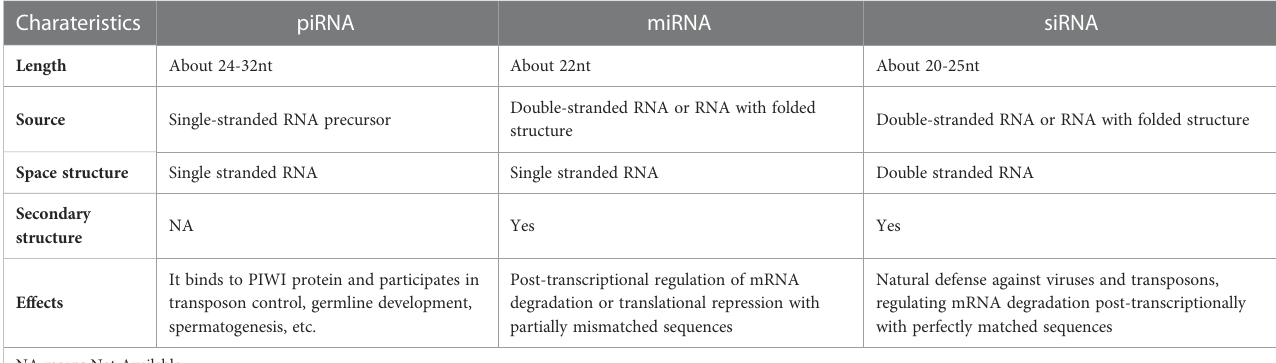
TABLE 1 Comparison of the three